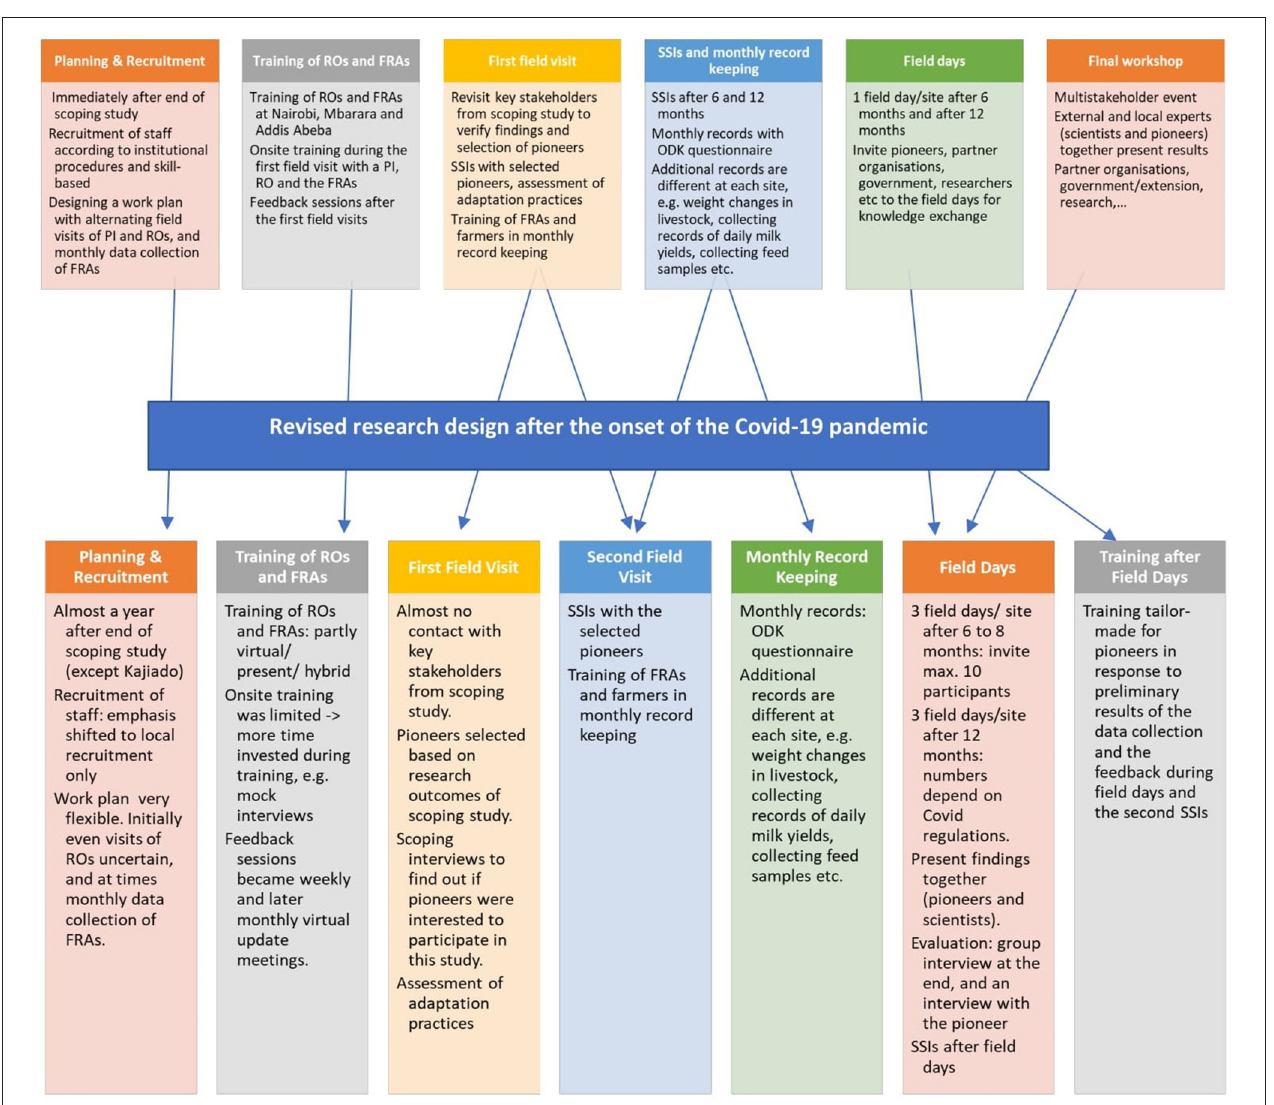
FIGURE 2 | Research design of the case study before and after the onset of the Covid-19 pandemic. The arrows indicate the direction we took after the onset of the